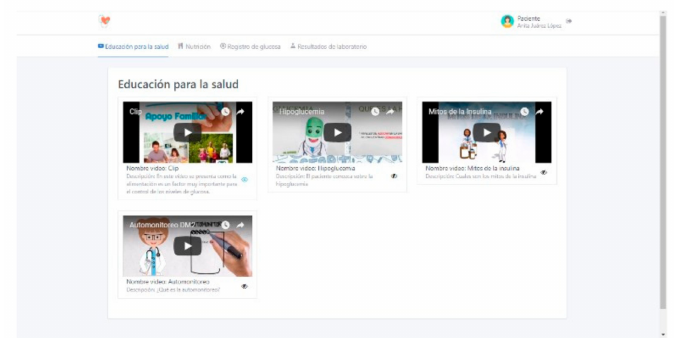
Figure 38. Patient application interface: Health education module.